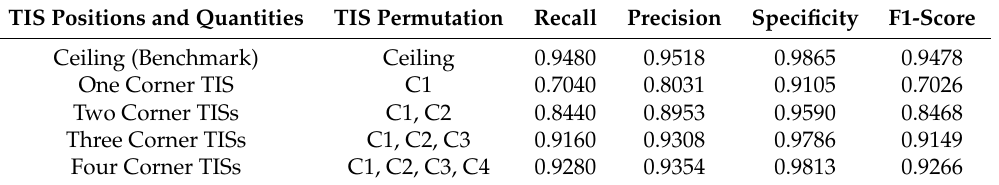
Table 15. The comparison of achieved recognition scores between the best scoring approaches for each TIS permutation and the